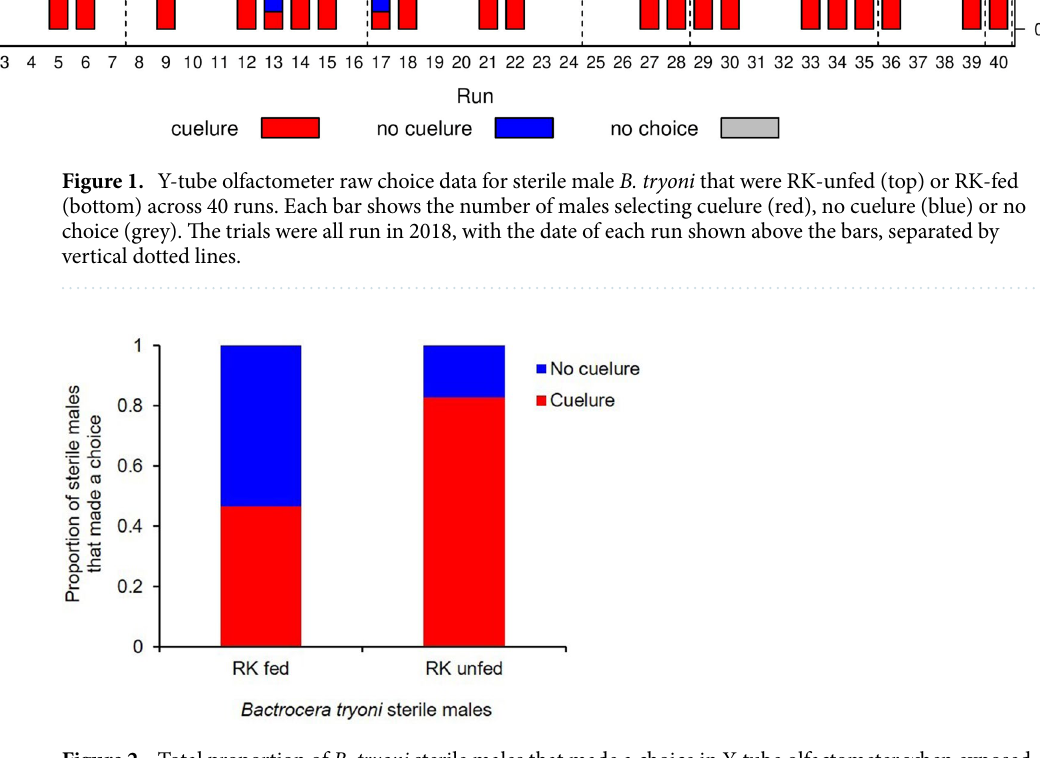
Figure 2. Total proportion of B. tryoni sterile males that made a choice in Y-tube olfactometer when exposed to cuelure. A significantly higher proportion of RK unfed sterile males chose the cuelure-baited arm compared with RK fed sterile males (p <